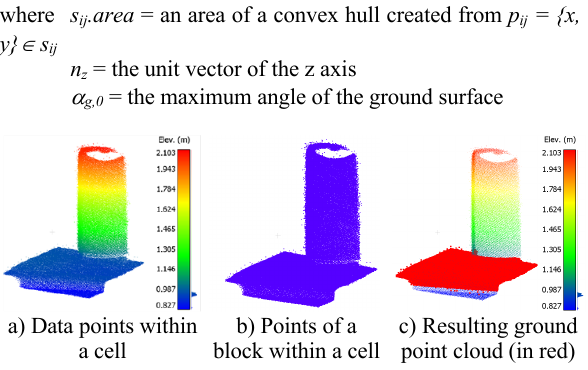
Figure 2 . Workflow of the proposed method to extract recycle bins